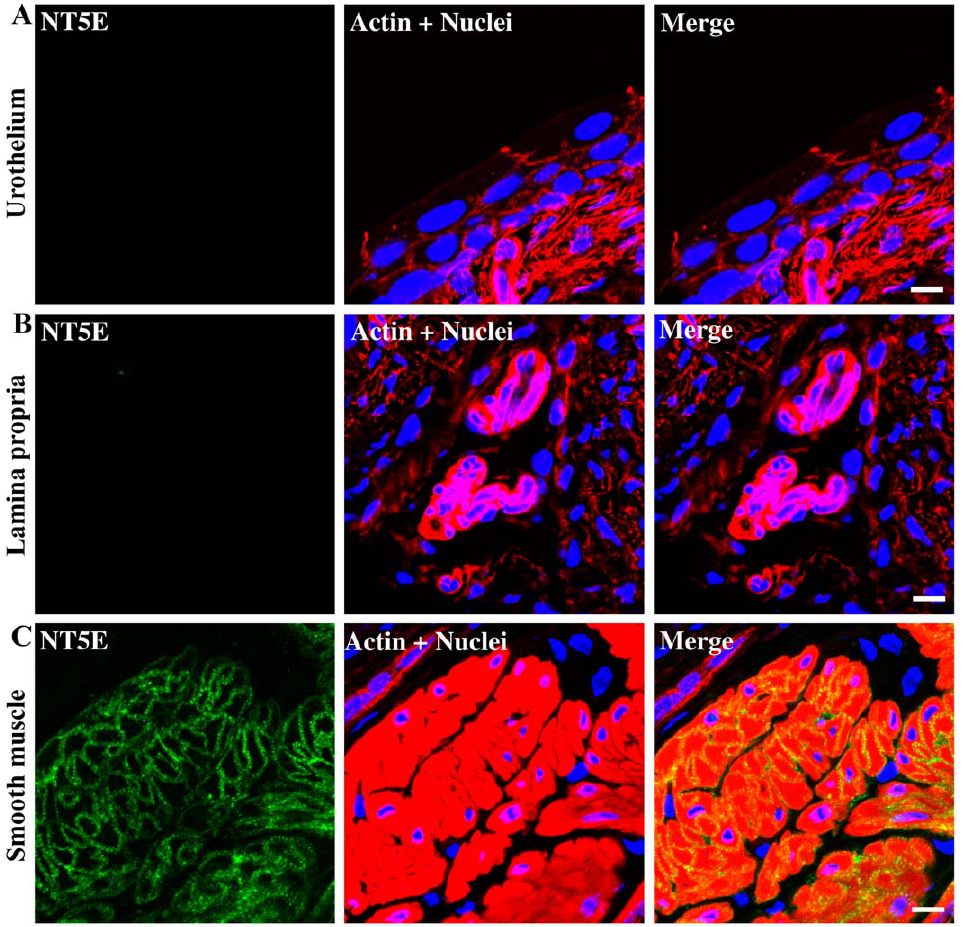
Figure 8. Immunolocalization of NT5E in different regions of the bladder. Cryosections of mouse bladders were labeled with antibodies to NT5E (green), rhodamine phalloidin to label the actin cytoskeleton (red) and Topro-3 to label nuclei (blue). Color merged panels are shown on the right. A) NT5E staining at the level of the urothelium, B) NT5E staining at the level of the lamina propria, C) NT5E staining at the level of the detrusor smooth muscle. White scale bars =10 m